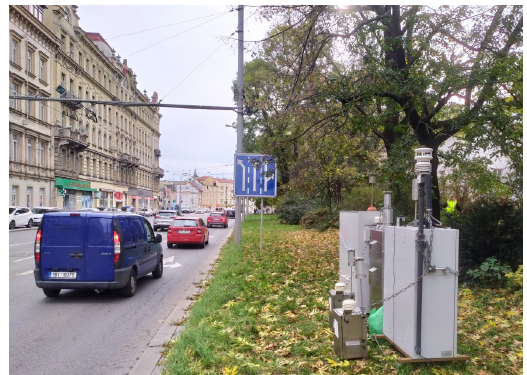
Figure 6. In-situ measurements of PM10 concentrations in urban roads.